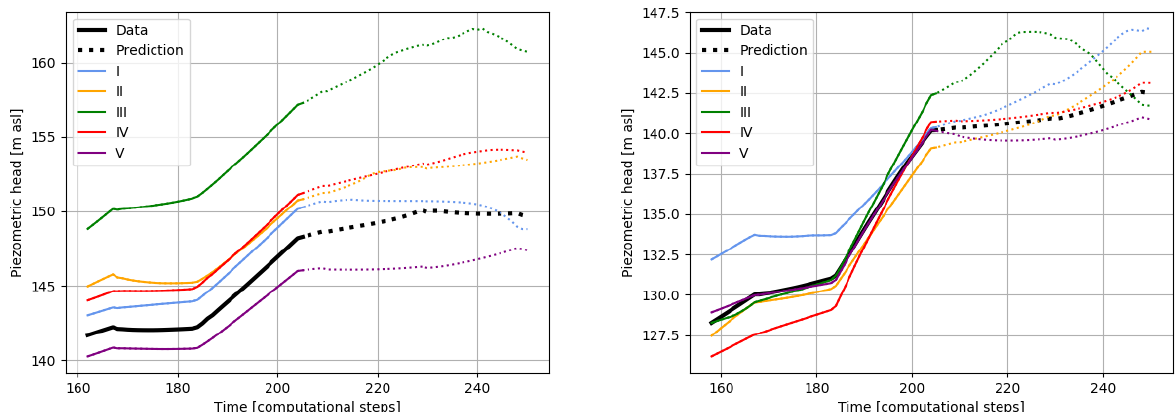
Figure 24: Prediction of piezometric head in piezometer P1 (left) and P2 (right).